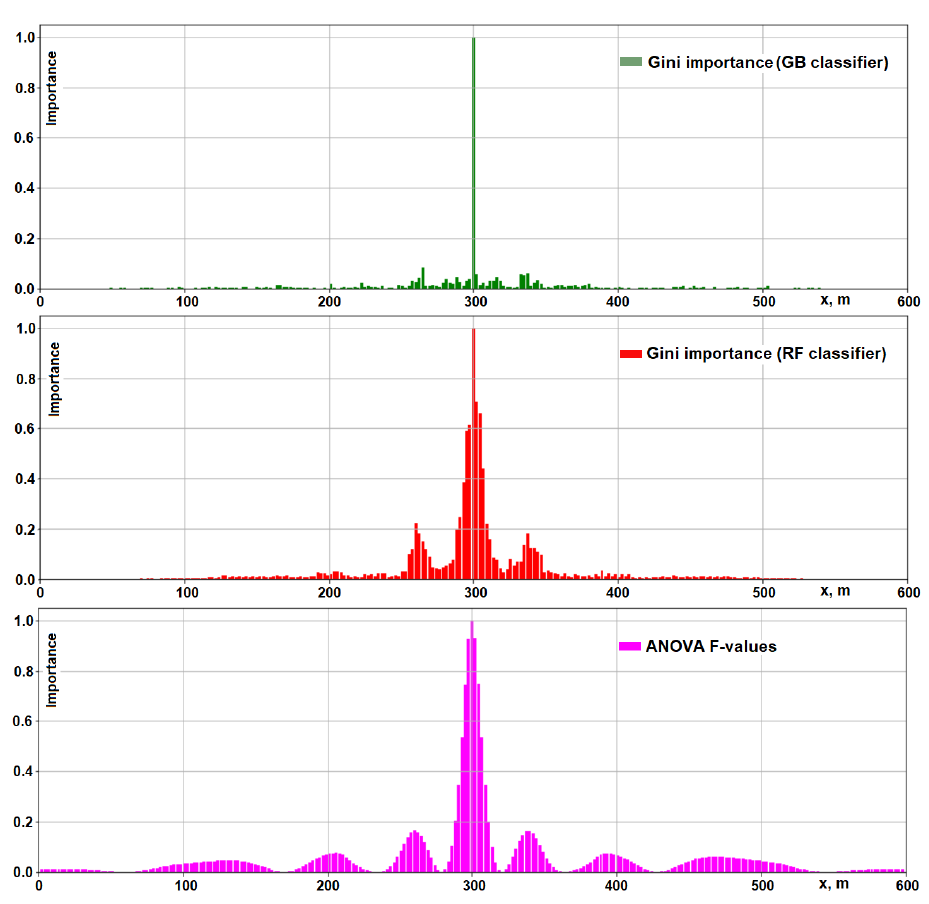
Figure 16. Feature importance at t = 9 years for the Type II models (scaled to the range [0, 1]).